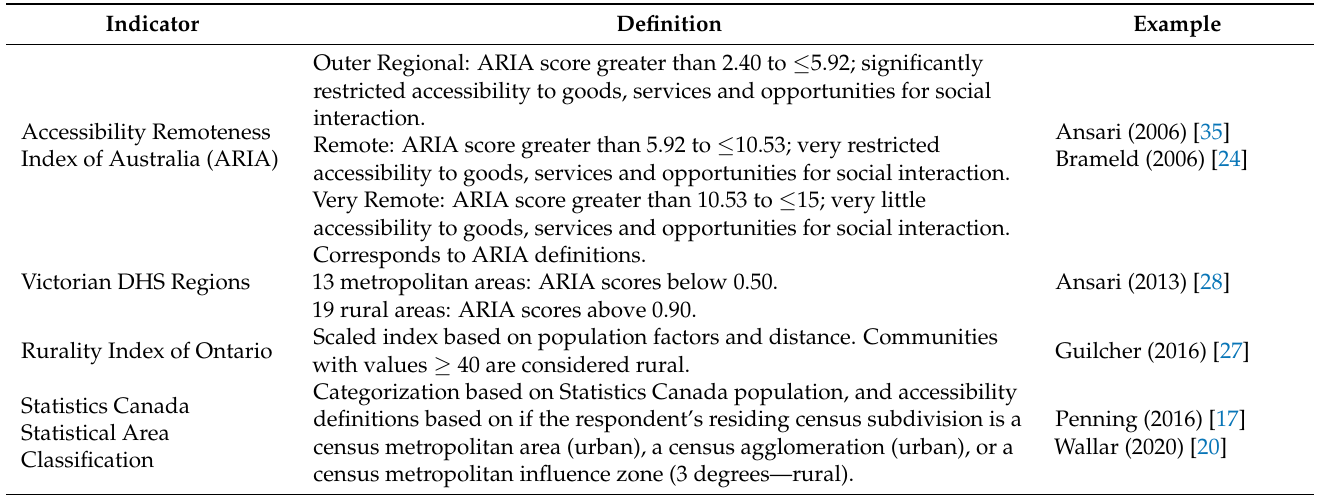
Table 2. Definitions of rurality in included